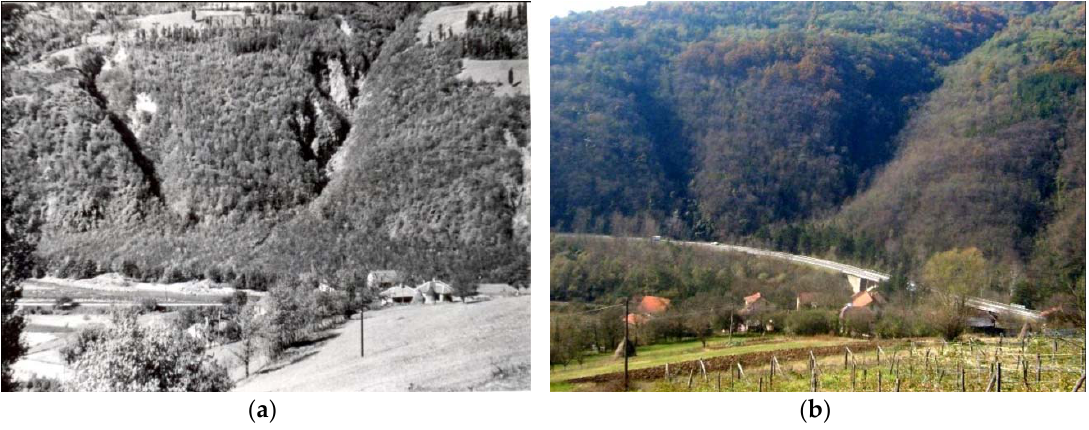
Figure 4. Land use change of Zla Dolina: ( a ) 1953 [58]; ( b ) 2016 (photo: S. Braunovi ć ).